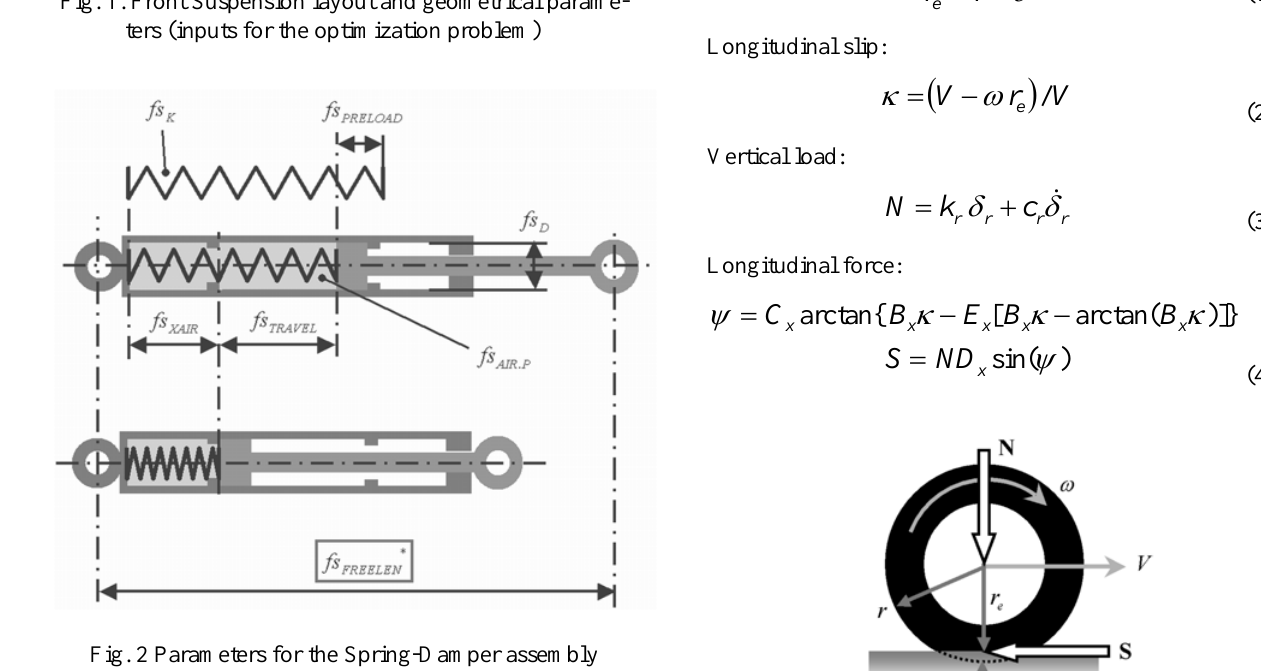
Fig. 2 Parameters for the Spring-Damper assembly (further inputs for the optimization